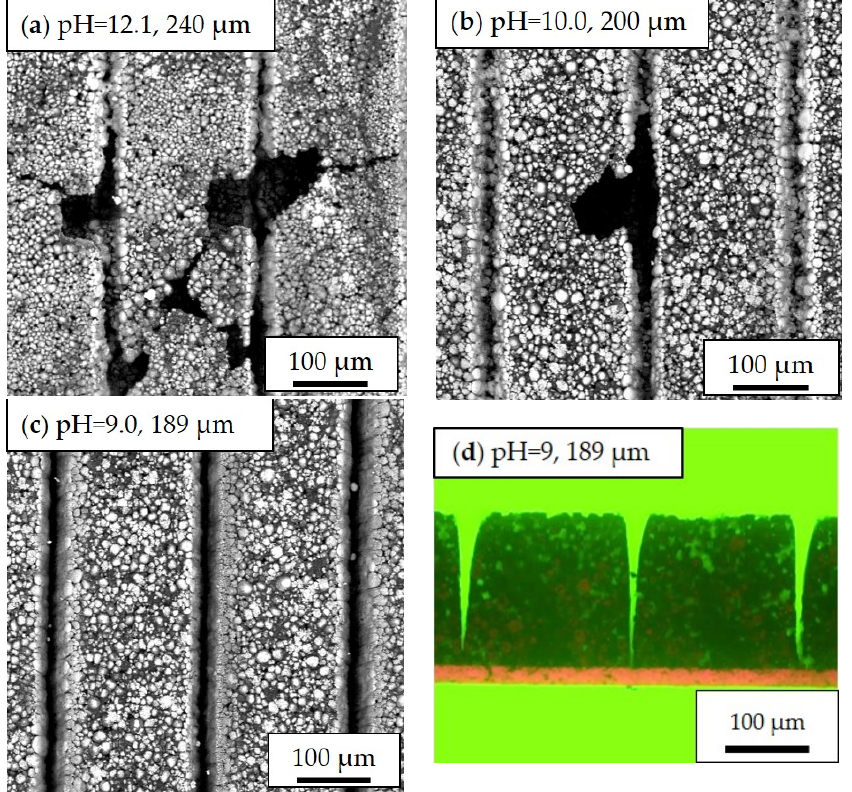
Figure 5. SEM images of structured cathodes with slurry pH values of ( a ) 12.1; ( b ) 10.9; and ( c ) 9.0; ( d ) Microscope image of cross sectional view of a laser structured cathode deposited with a slurry pH value of 9 and a film thickness of 189 µm.